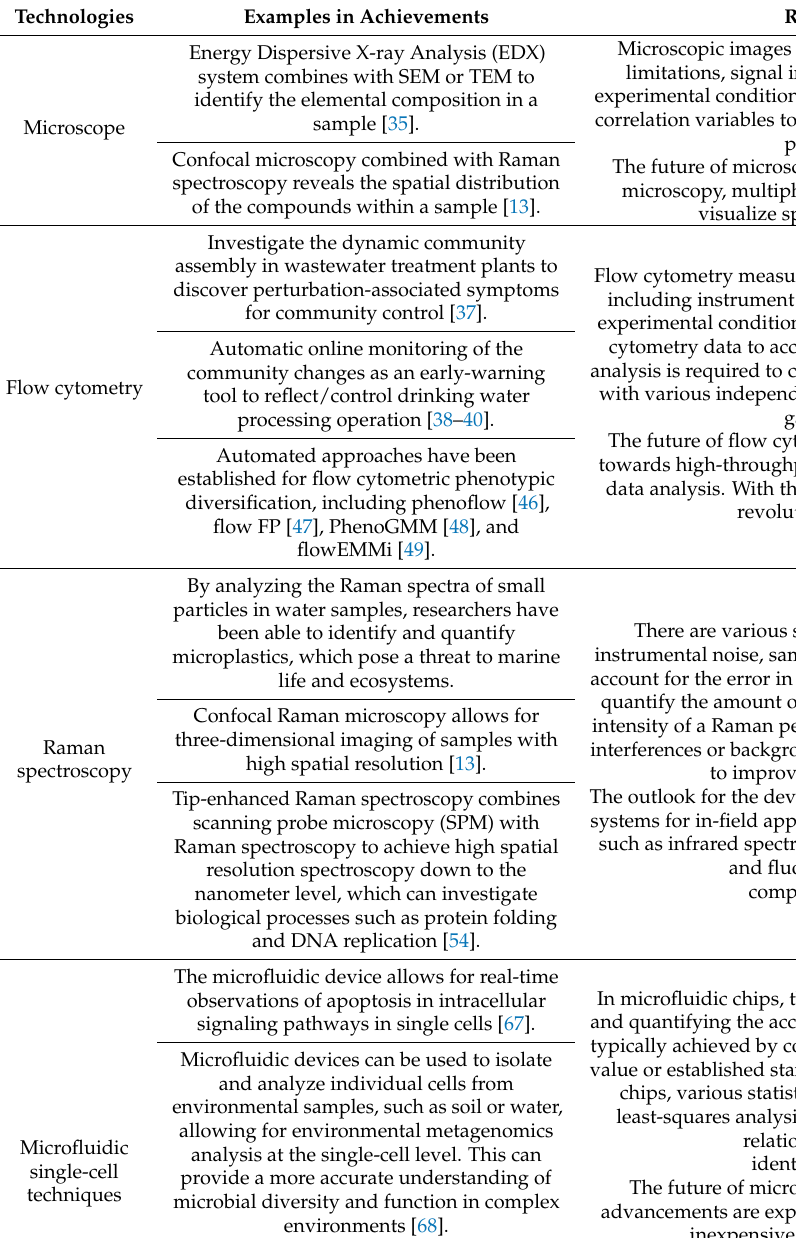
Table 1. A comparison table in terms of achievements and variations in the measurement and analysis of different